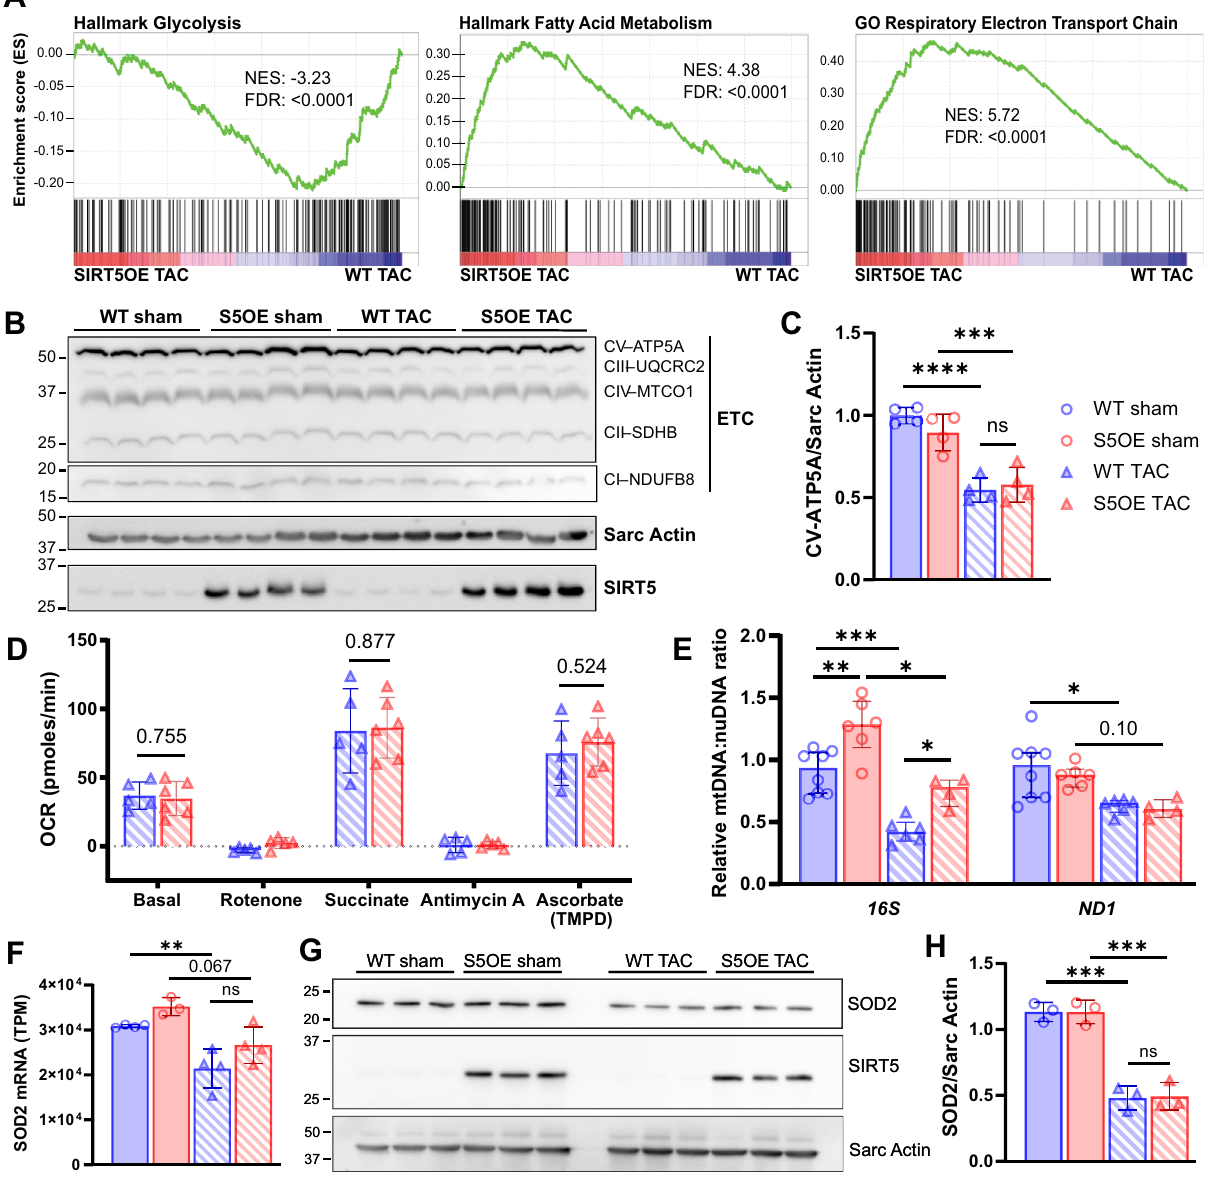
Figure 4. WT TAC mice exhibit a metabolic shift by RNA-seq, but are functionally comparable to SIRT5OE TAC mice four weeks post-surgery. (A) GSEA of SIRT5OE TAC compared to WT TAC RNA-seq samples. NES: normalized enrichment score. FDR: false discovery rate. (B-C) Immunoblot analysis of electron transport chain subunits and quantification of CV-ATP5A. Original immunoblot images are presented in Supplemental Fig. 8A. (D) Agilent/Seahorse analysis of electron flow through the ETC in mitochondria isolated from WT ( n = 5) and SIRT5OE ( n = 6) hearts 4 weeks after TAC. y-axis indicates oxygen consumption rate (OCR) in pmol/min. (E) qPCR of mitochondrially encoded (mtDNA) genes 16S and ND1 , normalized to HK2 , encoded by the nuclear genome (nuDNA). (F) Sod2 mRNA levels measured by RNA-seq. (G-H) SOD2 immunoblot from heart lysates and quantification. Original immunoblot images are presented in Supplemental Fig.